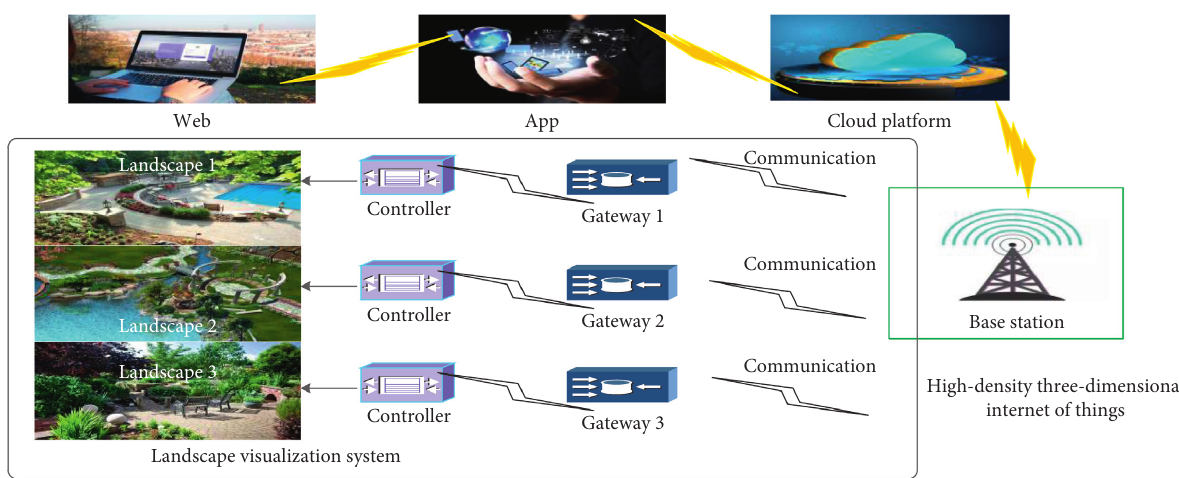
Figure 4: High-density three-dimensional Internet of Things landscape visualization system architecture